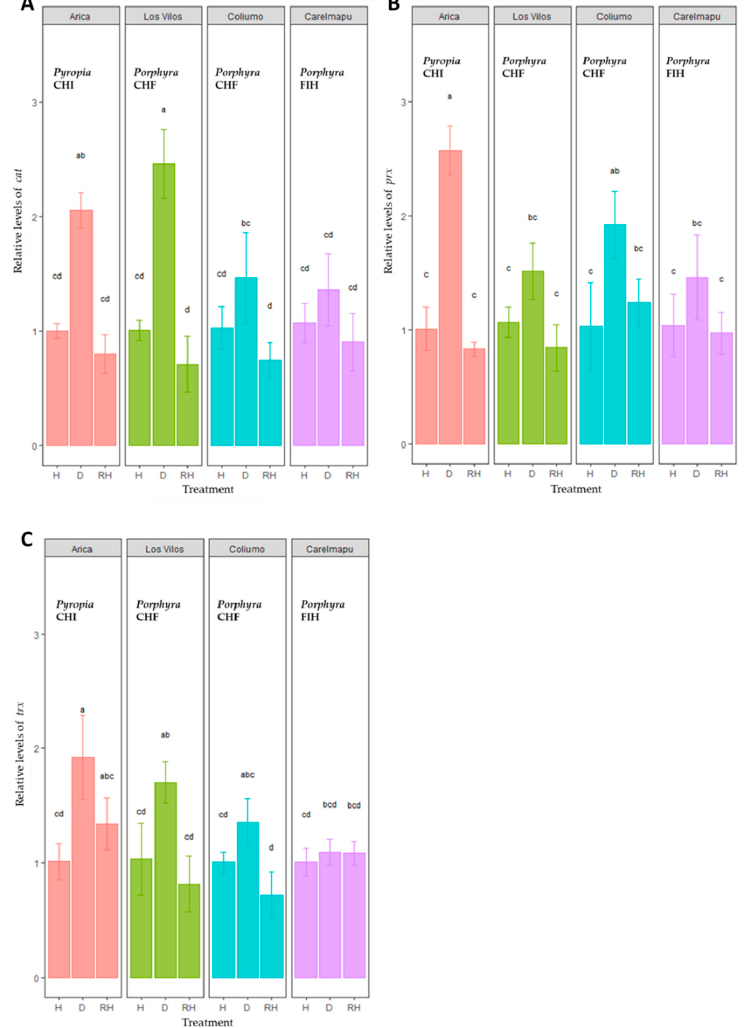
Figure 5. Relative expression level of ( A ) cat , ( B ) prx , and ( C ) trx transcripts during hydration (H), desiccation (D), and rehydration (RH) cycle in Porphyra and Pyropia species (see Table 1 and Figure 6 for details). Values are the mean ± SD of three replicates. The letters above the bar plots indicate the results of Tukey’s tests; means with the same letter are not significantly different at p ≥ 0.05. The colors of the histograms correspond to the sites evaluated.